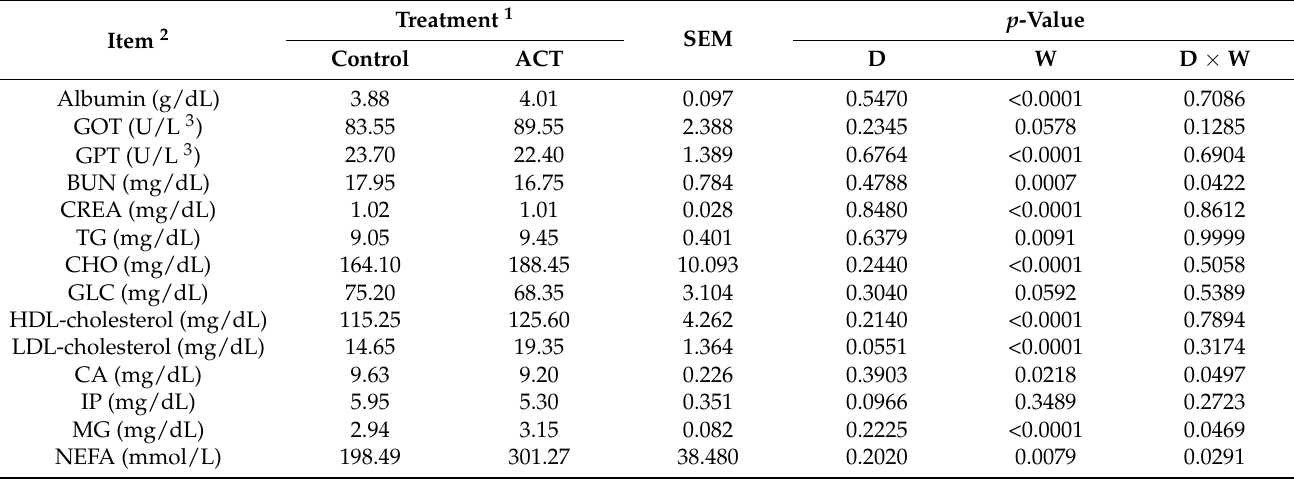
Table 9. Serum metabolic profile of cows postpartum.